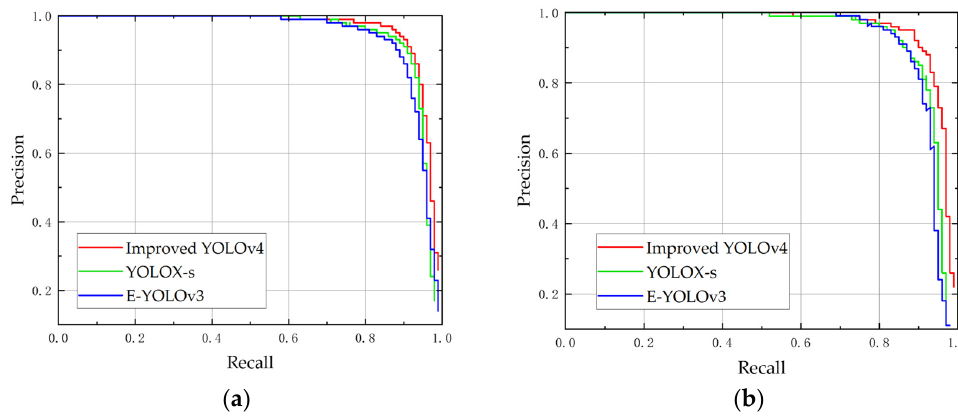
Figure 11. P–R curve for comparison: ( a ) Plot of ripe_apple; and ( b ) plot of unripe_apple. Table 4. Comparison test results of three models.